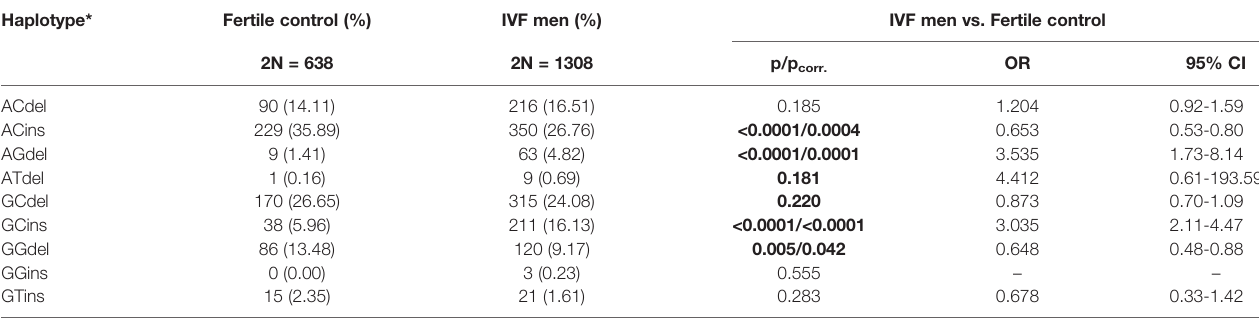
*Haplotypeswereestimatedinthefollowingorder:rs1632947:-964G>A;rs1233334:-725G>C/T;rs371194629:insATTTGTTCATGCCT/del.Valuesinboldindicatesigni fi cantdifferences. IVF,invitrofertilization;p, probability;p corr. ,probabilityafterBonferronicorrectionfor9possiblehaplotypes;OR,oddsratio;95%CI,con fi denceintervalfromtwo-sidedFisher ’ sexacttest; ns, not signi fi